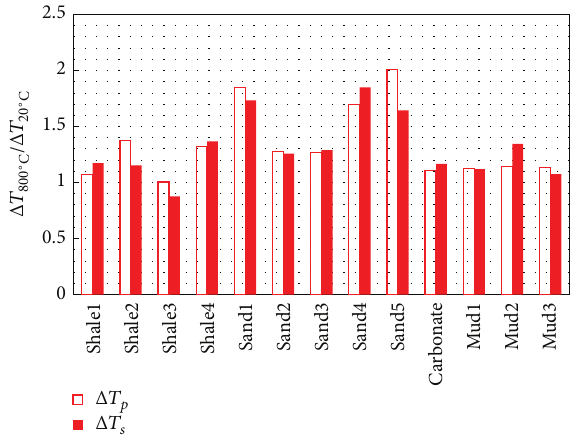
Figure 3: Ratio of acoustic transit time at 800 ∘ C to that at 20 ∘ C for all the